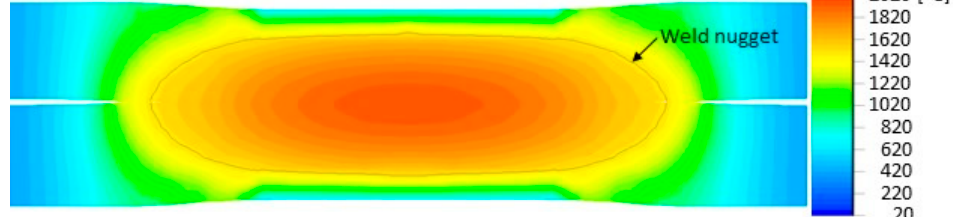
Figure 4. Distribution of simulated peak temperature in resistance spot-welding together with identification of the weld nugget.